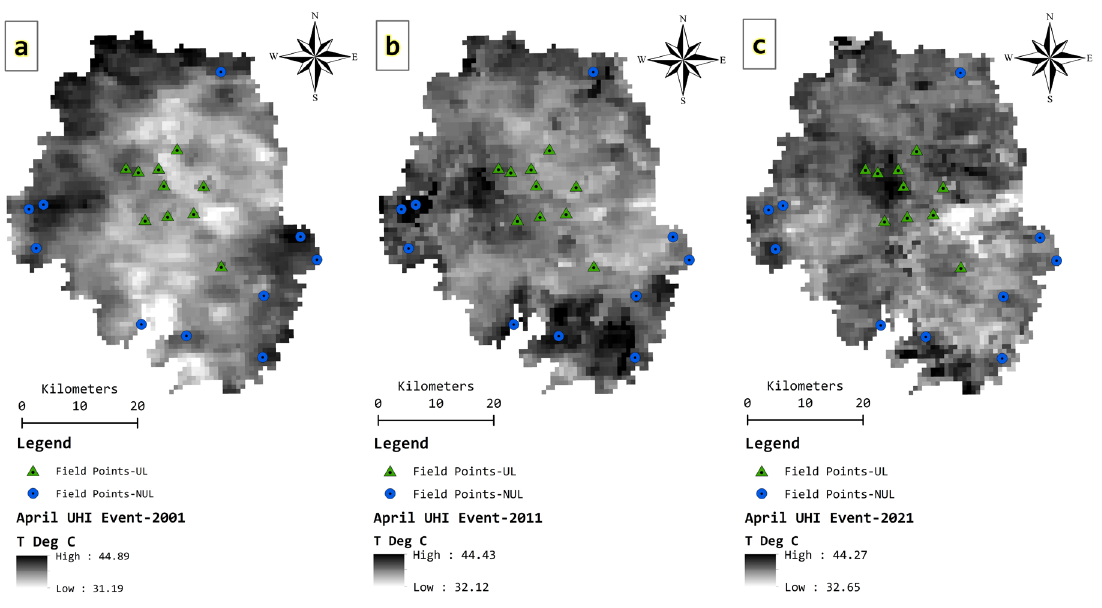
Figure 11. Urban heat island events of April ( a ) 2001, ( b ) 2011, and ( c ) 2021. Green triangle symbols are the urban and blue ones are the non-urban observation sites.